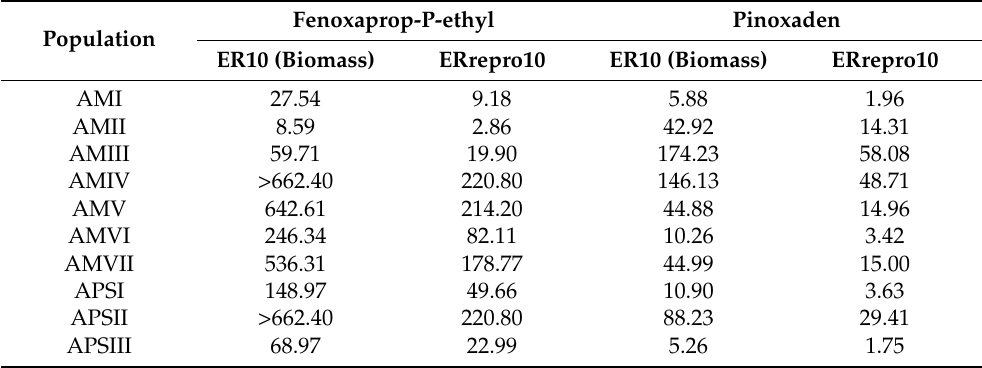
Table 2. Calculated ERrepro10 (g a.s. ha − 1 ) values for A. myosuroides (AMI–AMVII) and A. spica-venti (APSI–APSIII) populations treated with fenoxaprop-P-ethyl and